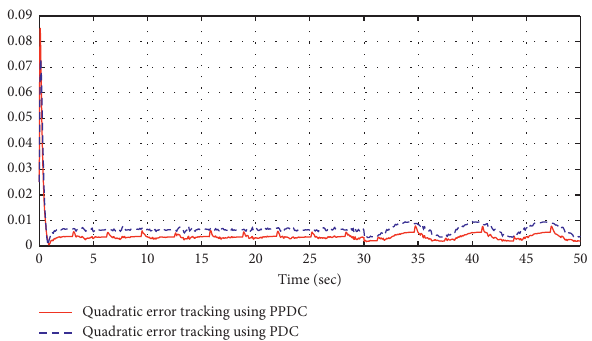
Figure 7: Quadratic error tracking using PDC and PPDC